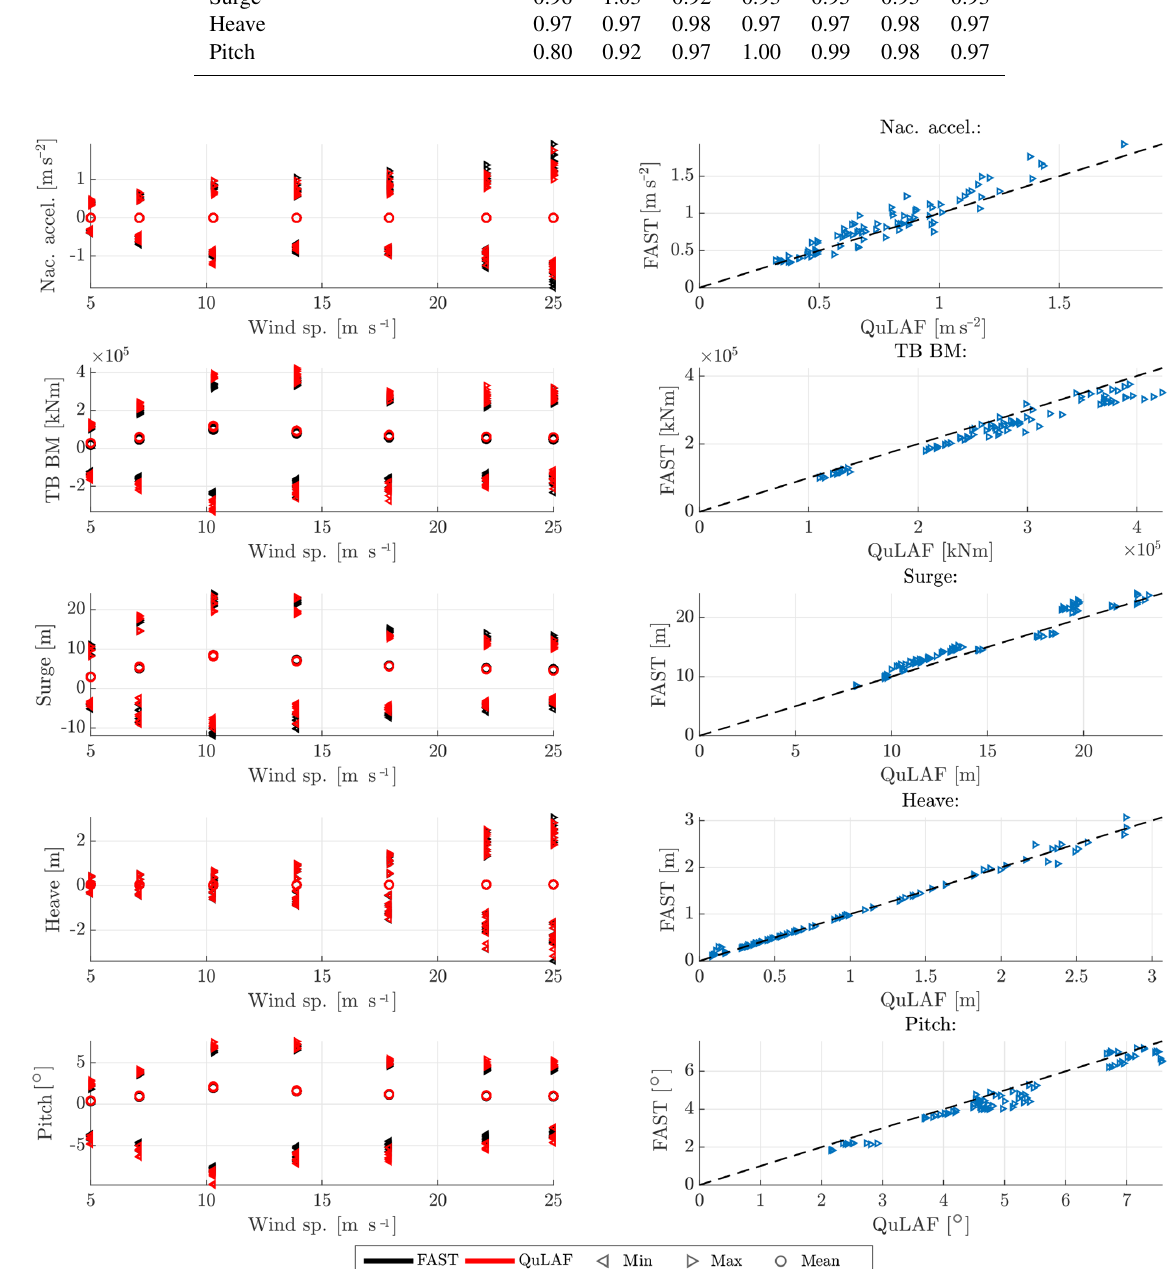
Figure 6. Response to DLC2.1 for FAST and QuLAF. Left: min., max. and mean values for every realization as a function of wind speed. Right: maximum values for FAST as a function of the corresponding maximum values in